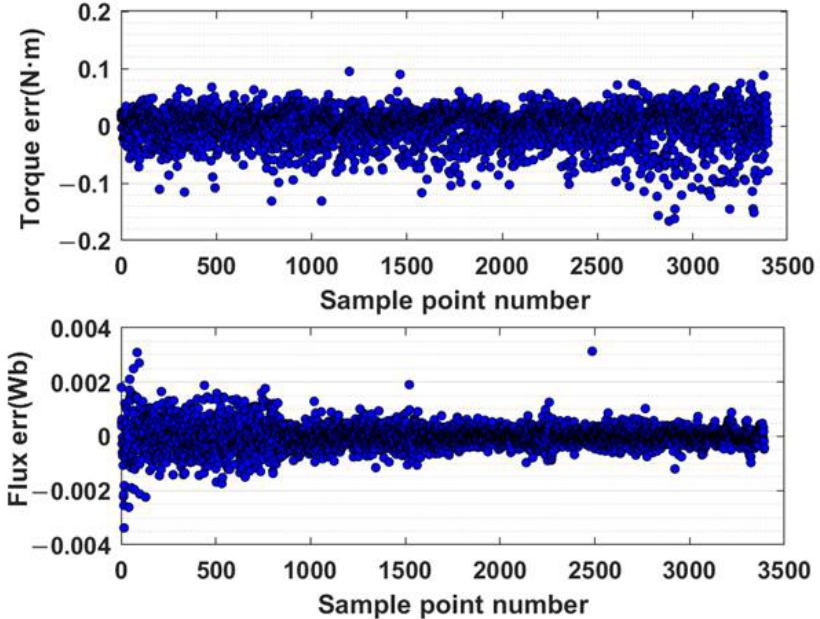
Figure 17. Error of torque model.